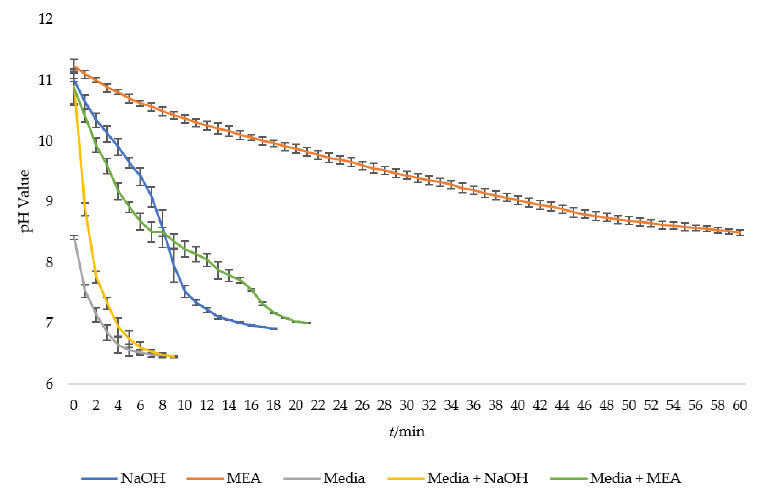
Figure 3. Effect of pH change for five absorbents at p = 100 kPa, T = 20 °C, with an initial pH of 11 with Figure 3. E ff ect of pH change for five absorbents at p = 100 kPa, T = 20 ◦ C, with an initial pH of 11 with exception of culture media with an initial pH of 8.5. exception of culture media with an initial pH of